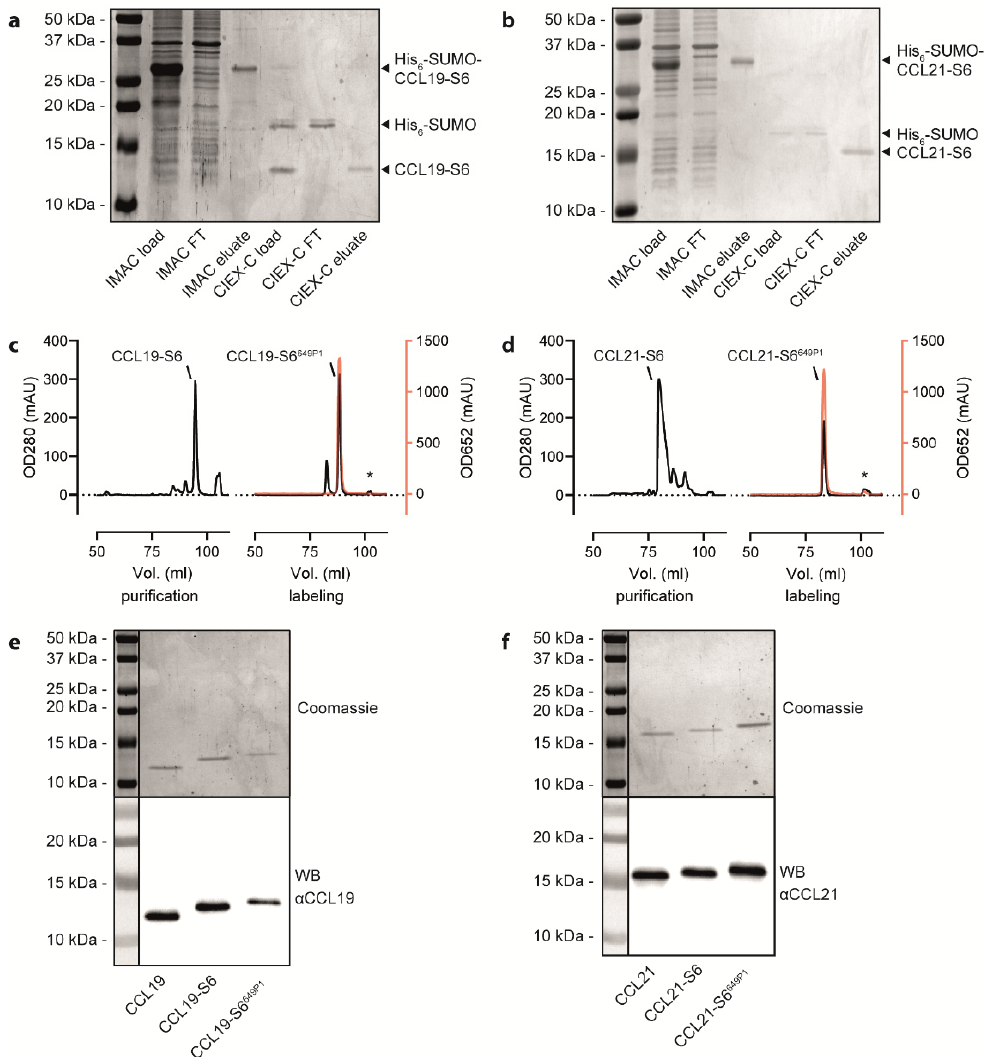
Figure 2. Purification and fluorescent labelling of human CCL19 and CCL21. ( a , b ) Representative Coomassie-stained SDS-PAGE gels with samples derived from the bacterial cell lysate before loading on the IMAC column, the IMAC flow through (FT), the IMAC eluate, the CIEX-C load after cleaving the His 6 -SUMO-tag, the CIEX-C flow through (FT) and CIEX-C eluate for the CCL19-S6 ( a ) and CCL21-S6 ( b ) purification steps illustrated in Figure 1b. ( c , d ) Representative HPLC chromatograms displaying the volume of gradient elution of CCL19-S6 ( c ) or CCL21-S6 ( d ) from a C-18 column used to separate correctly folded from misfolded chemokines (left panels) and to separate the fluorescently labeled chemokine from unlabeled chemokine, free substrate and the Sfp-CoA-Dy 649P1 (marked with *). Protein concentration was determined by measuring its absorbance at 280 nm (OD280); fluorescence was measured at 652 nm (OD652) and illustrated in red. ( e , f ) Representative Coomassie-stained SDS-PAGE gels (upper panels) and corresponding Western blots (WB, lower panels) of the same samples of native, S6-tagged and S6-tagged, as well as fluorescently labeled CCL19 ( e ) and CCL21 ( f ).